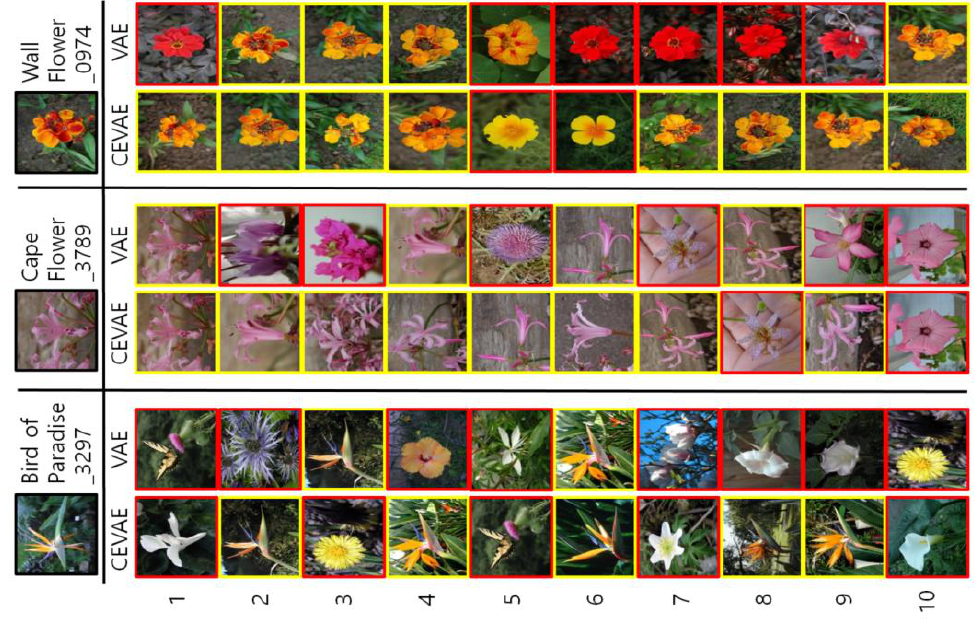
Figure 4. Comparison between the VAE and CEVAE on the Oxford Flowers dataset.